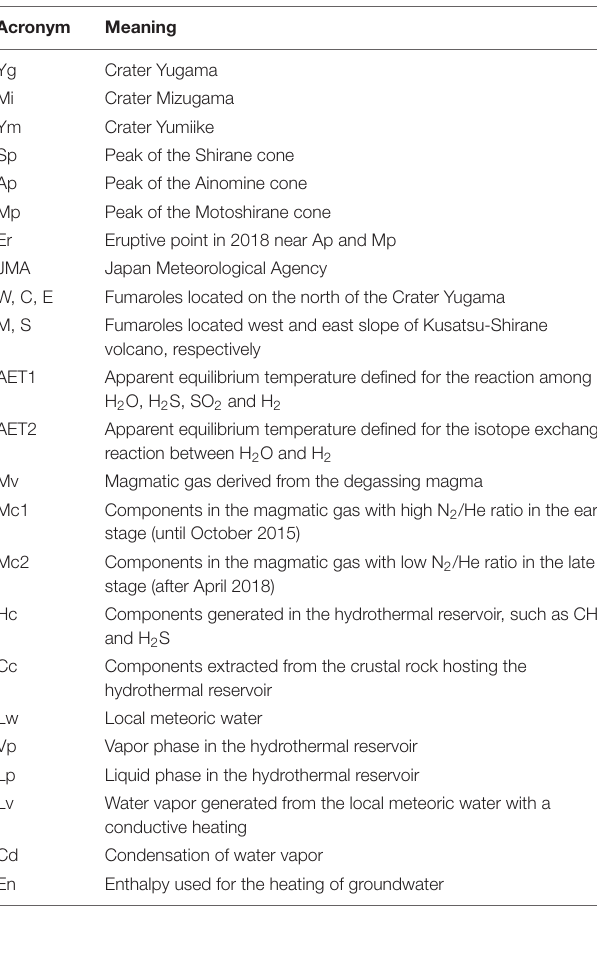
TABLE 1 | Acronyms used in the